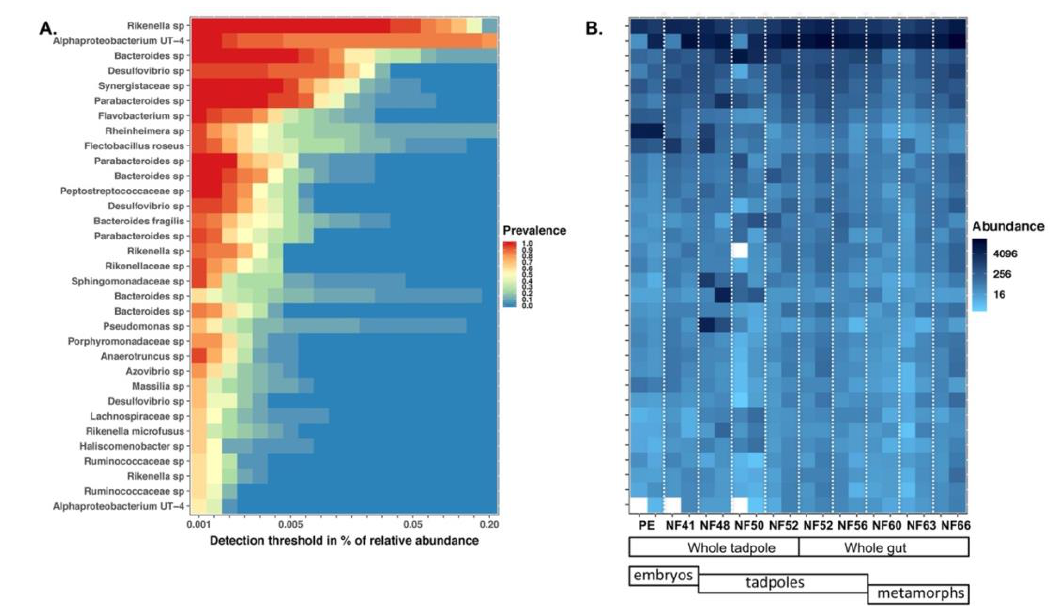
Figure 4. Prevalence and abundances of active bacteria across Xenopus development from post- hatching to metamorphosis. A. Heatmap of prevalence and abundances for 33 OTUs. The detection threshold scale is logarithmic and the metric used was the relative abundance. OTUs were identified